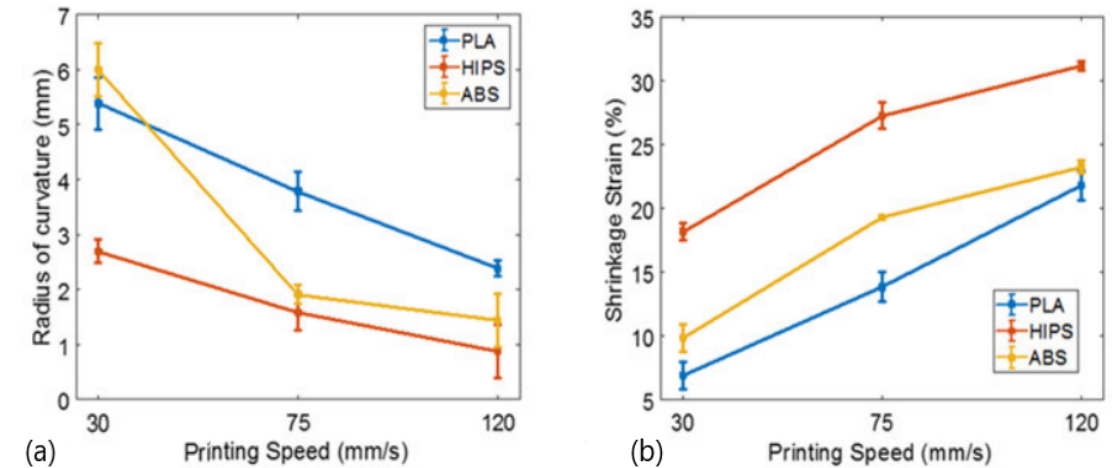
Figure 3. Effect of printing speed on the: ( a ) radius of curvature; ( b ) shrinkage strain [48]. Material from: Rajkumar, A.R.; Shanmugam, K, Additive manufacturing-enabled shape transformations via FFF 4D printing, published (2018) (Springer Nature) reproduced with permission of